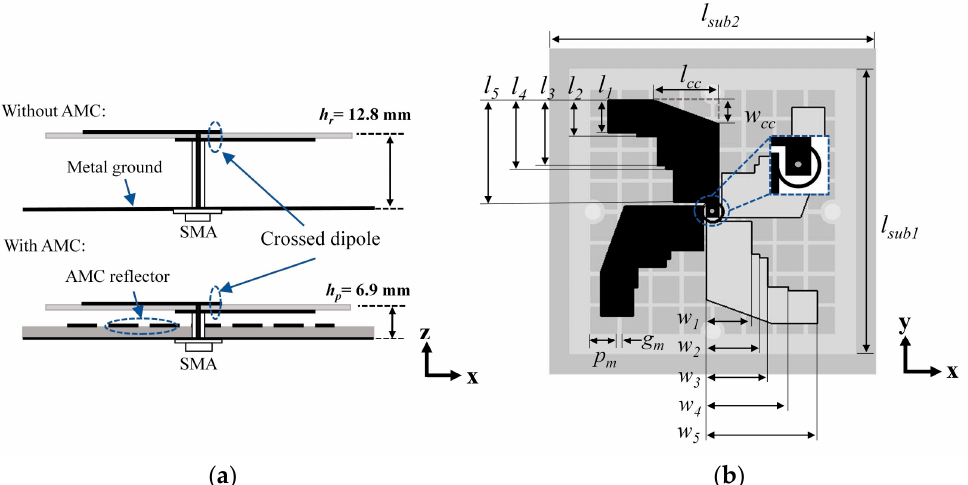
Figure 5. ( a ) The side view of the reference antenna and the proposed antenna. ( b ) Configuration of the proposed antenna and details of the dominant radiator.